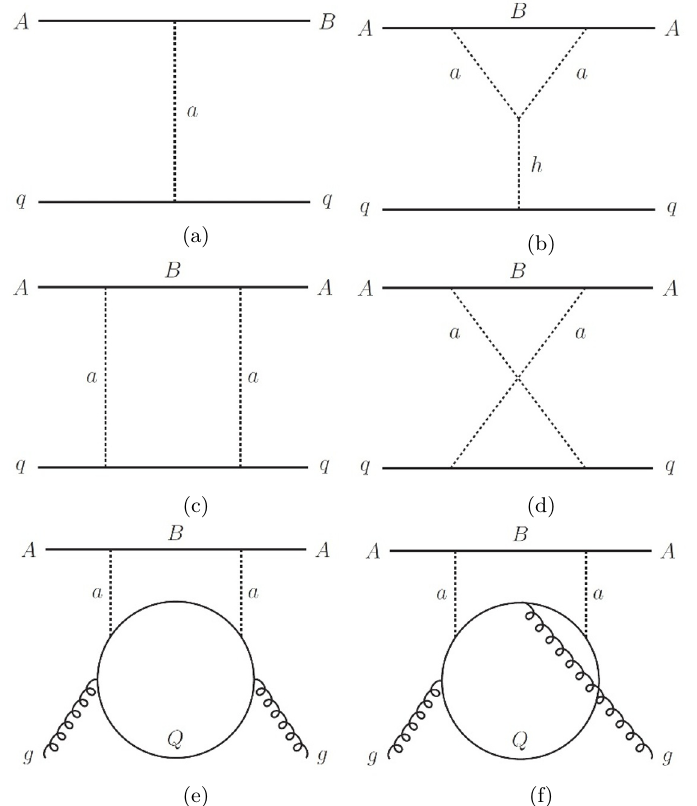
Figure 1 . Diagrams for the processes of neutrino interacting with quark or gluon. For incoming neutrino processes, A = ν, B = χ